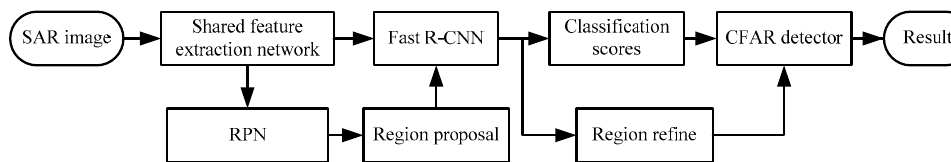
16 of 30 Figure 15. Structure of target detection model with multi ‐ features in SAR images. In addition, Faster R ‐ CNN [93] was modified to improve detection performance in SAR images. Kang et al. [70] introduced a CNN ‐ based detection method combining fea ‐ tures and pixels in which the Faster R ‐ CNN framework was modified by the traditional CFAR detection algorithm for small ‐ sized targets detection, which is presented in Figure 16. For targets with clearer shape and structure, Faster R ‐ CNN gave higher classification scores, while for those small ‐ sized targets with smaller bounding boxes, the classification score was relatively low. CFAR was employed because this detector relies on the ampli ‐ tude of the pixel rather than the shape or structure of the target. The combination of de ‐